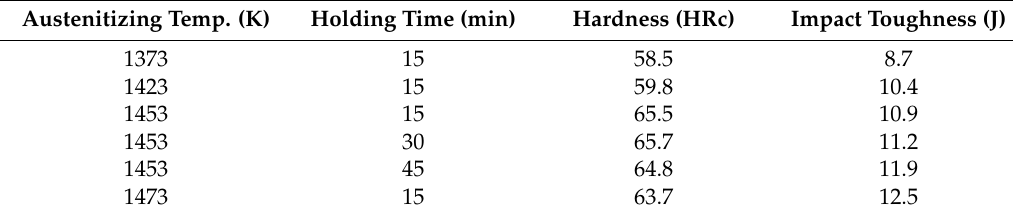
Table 2. Effects of austenitizing conditions on hardness and impact toughness of AISI M42 HSS. Austenitizing Temp.